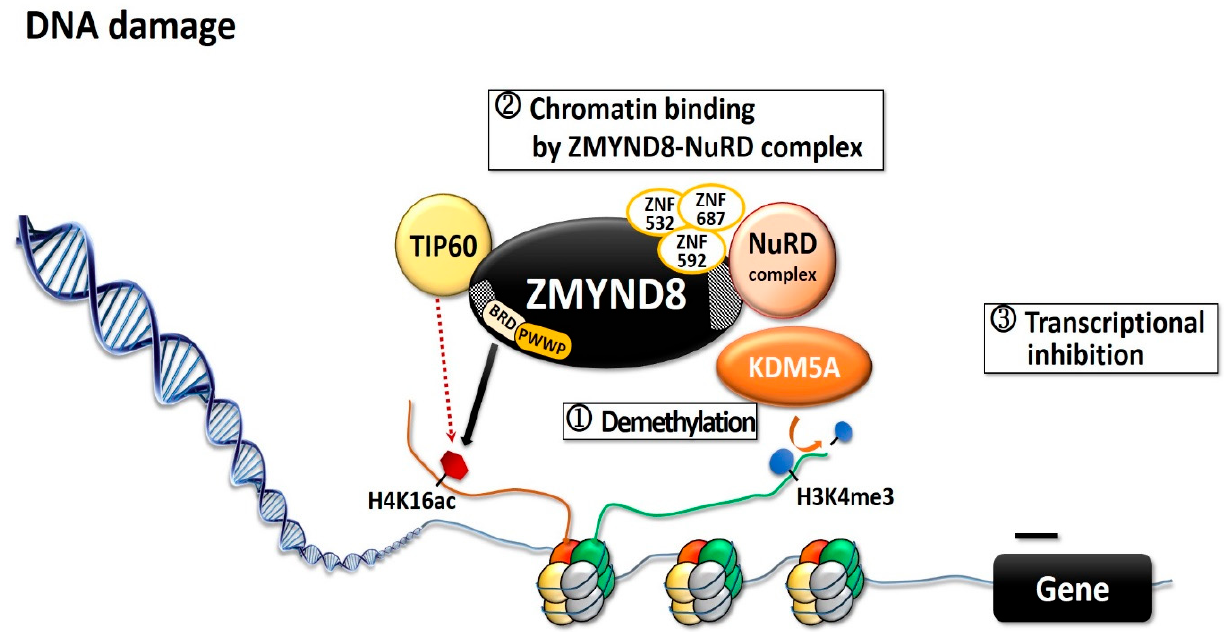
Figure 2. Diagram showing the KDM5A–ZMYND8–NuRD pathway during DNA damage. Upon DNA damage, the hisTable 5. A. ZMYND8 interacts with the NuRD complex and recognizes the TIP60-dependent acetylation. Then ZMYND8–NuRD complex binds to the DNA damaged site, inhibits transcription, and promotes DNA repair. TIP60: Histone acetyltransferase Tat-interactive protein-60KDa; NuRD: Nucleosome remodeling and deacetylase; KDM5A: Lysine demethylase 5A; H4K16ac: Acetyl lysine 16 of H4; H3K4me3: Tri-methyl lysine 4 of H3.